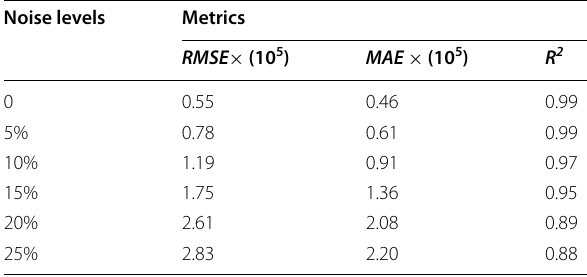
Table 1 Prediction performance of hoist forces at different noise levels